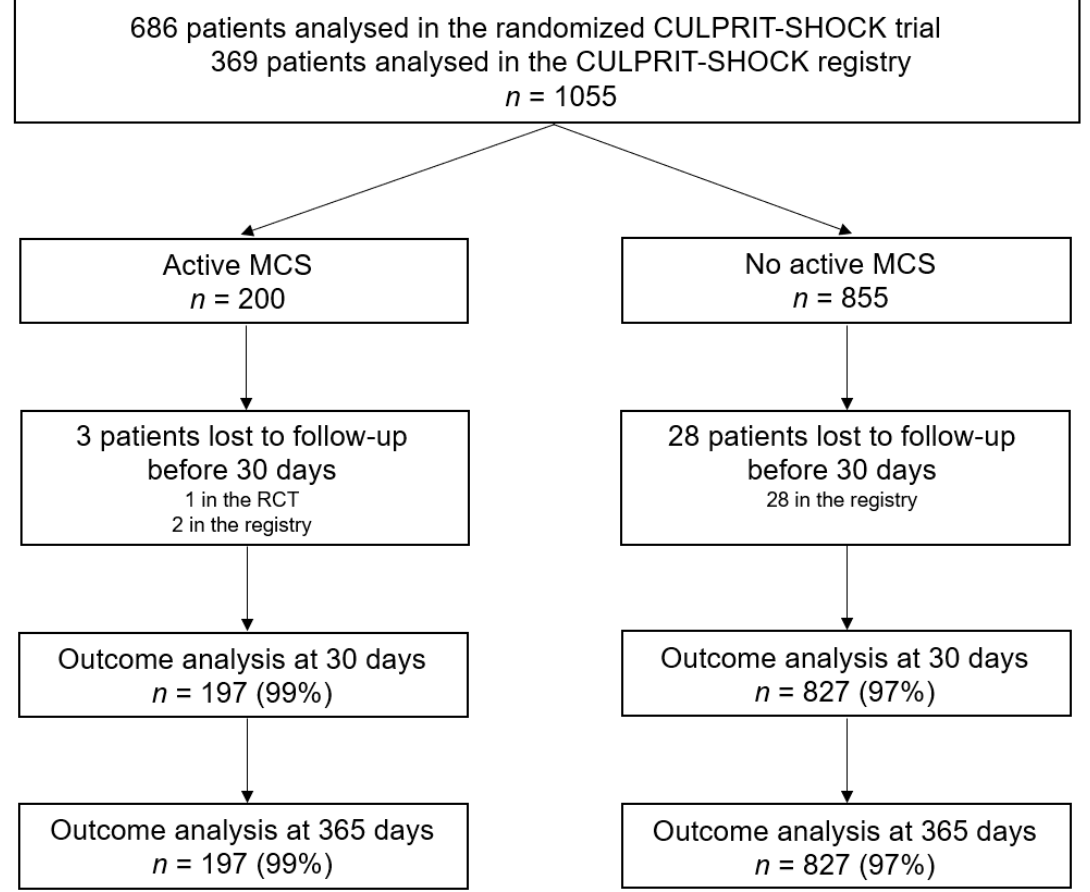
Figure 1. Study flow chart MCS = mechanical circulatory support; RCT = randomized controlled trial.